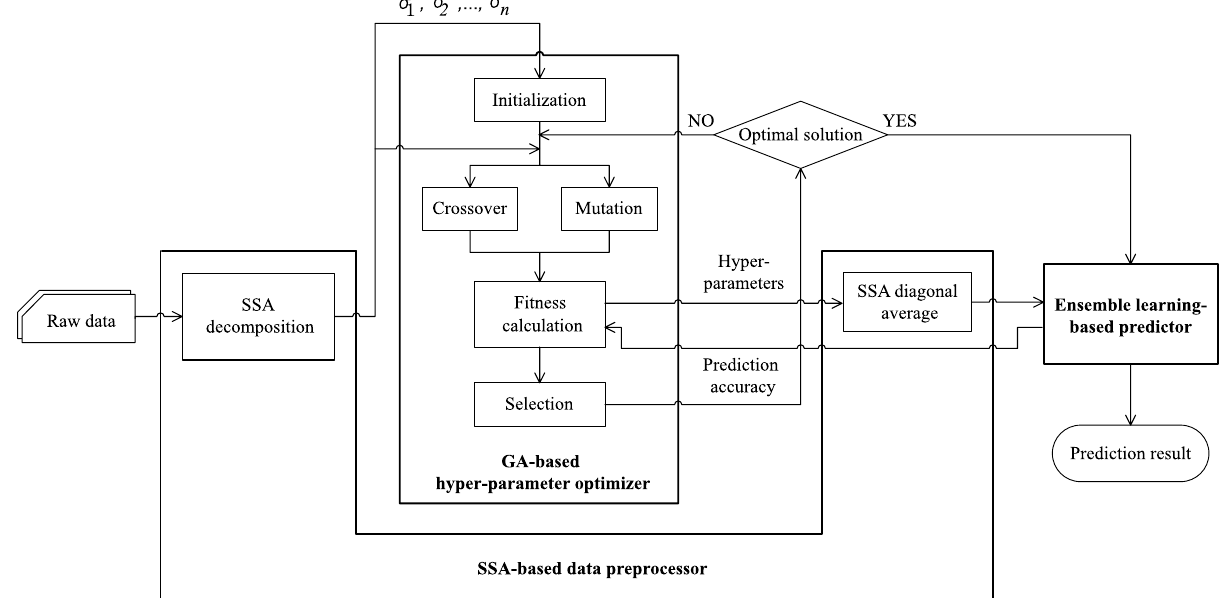
Figure 3. Overview of the proposed model. The SSA-based data preprocessor is responsible for decomposing the raw data into multiple elementary matrices. The GA-based hyper-parameter optimizer determines the sub- optimal parameters for the ensemble learning-based predictor using genetic operations. Finally, the ensemble learning-based predictor forecasts the Q and H values using an ensemble